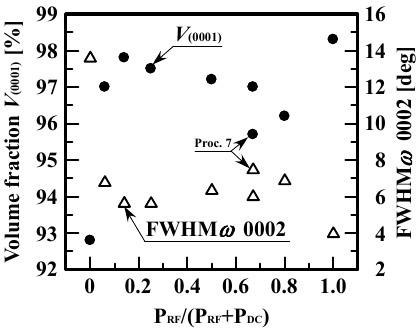
Figure 7. Volume fraction of grains with the (0001) orientation ( V (0001) ) and the values of the full width at half maximum (FWHM) of the ω rocking curves of the 0002 reflection of AZO films as a function power ratio, P RF /(P RF + P DC ).